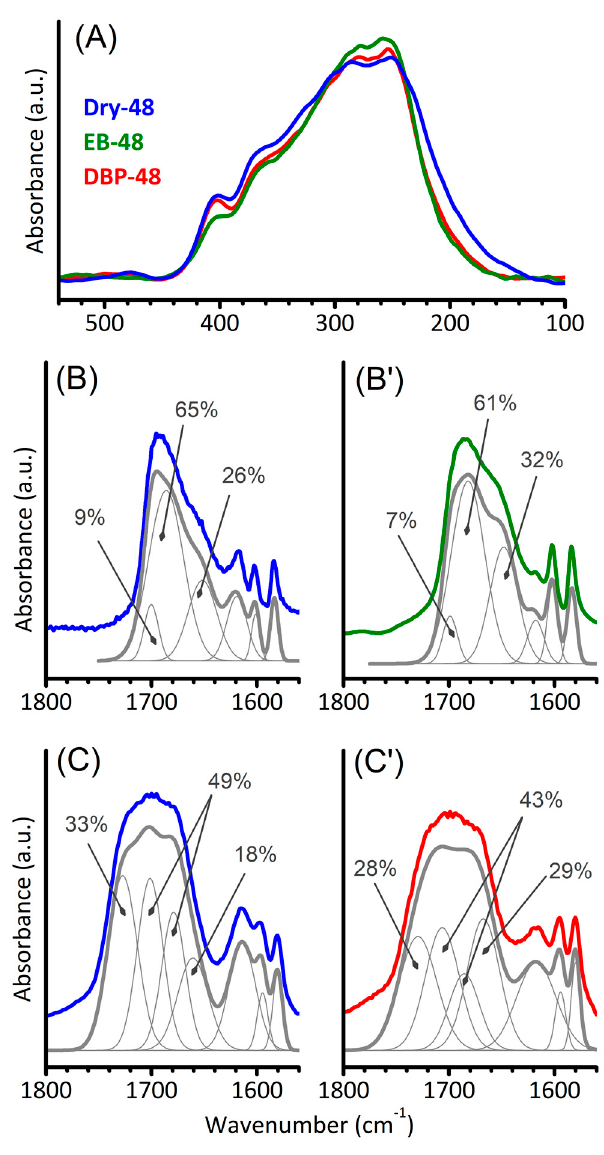
Figure 4. ( A ) Far IR spectra of Dry-48, EB-48 and DBP-48 samples. ( B , B’ ) Curve fitting of FT-IR spectra in the ν (C = O) region for EB adsorbed on Dry-48 and for EB-48, respectively. ( C , C’ ) The same as B and B’ for DBP adsorbed on Dry-48 and for DBP-48, respectively. Percentages are reported for the signals associated to the donors’ carbonyls, according to literature.